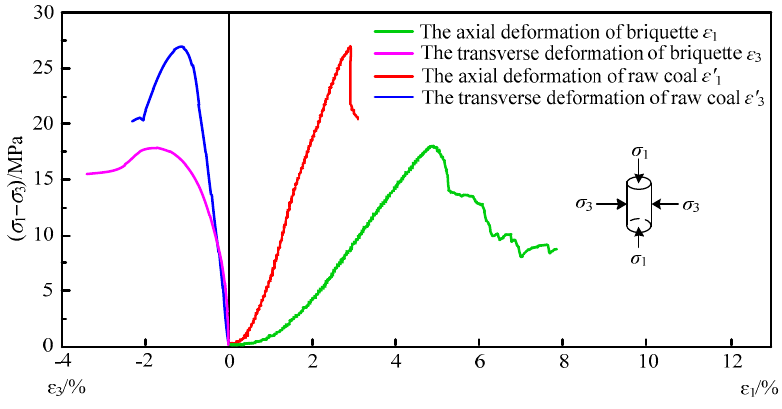
Figure 5. Complete stress–strain curves of briquette and raw coal.